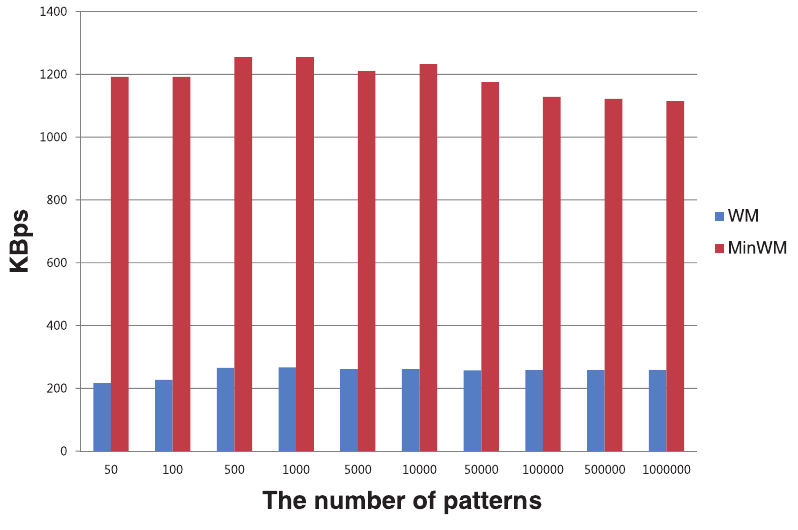
Figure 8. The average throughput of the two pattern sets in the base